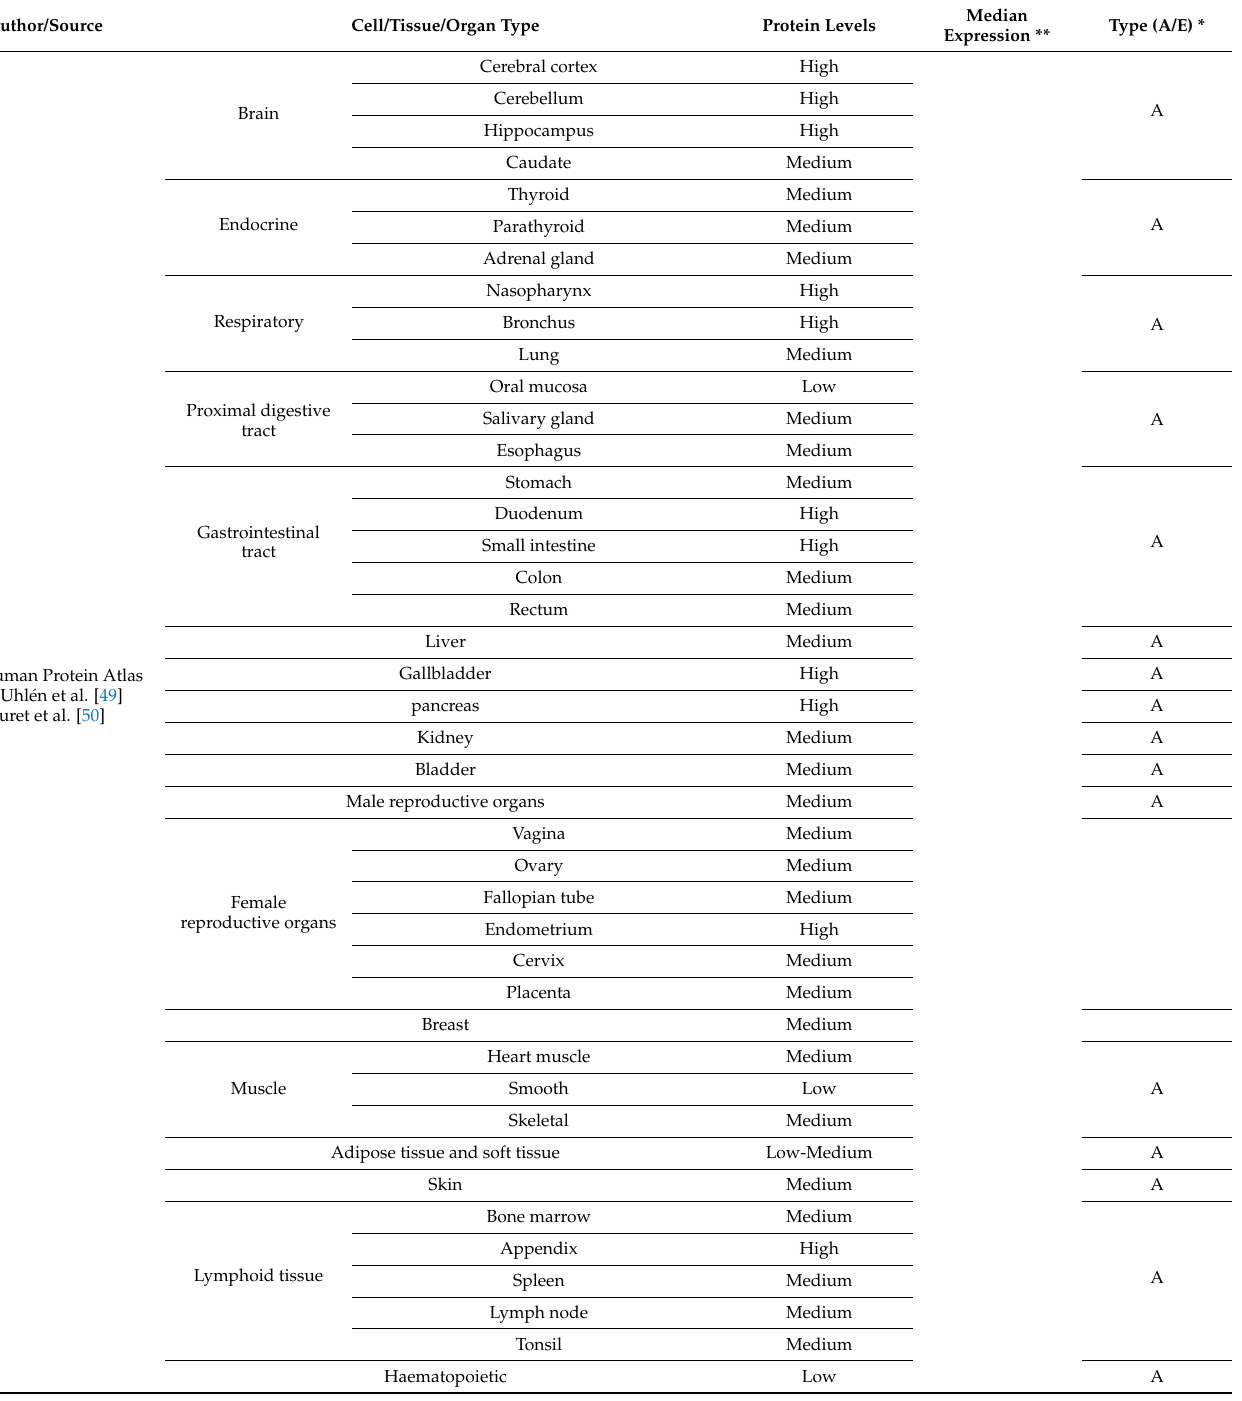
Table 1. CSPG4 expression in non-cancer